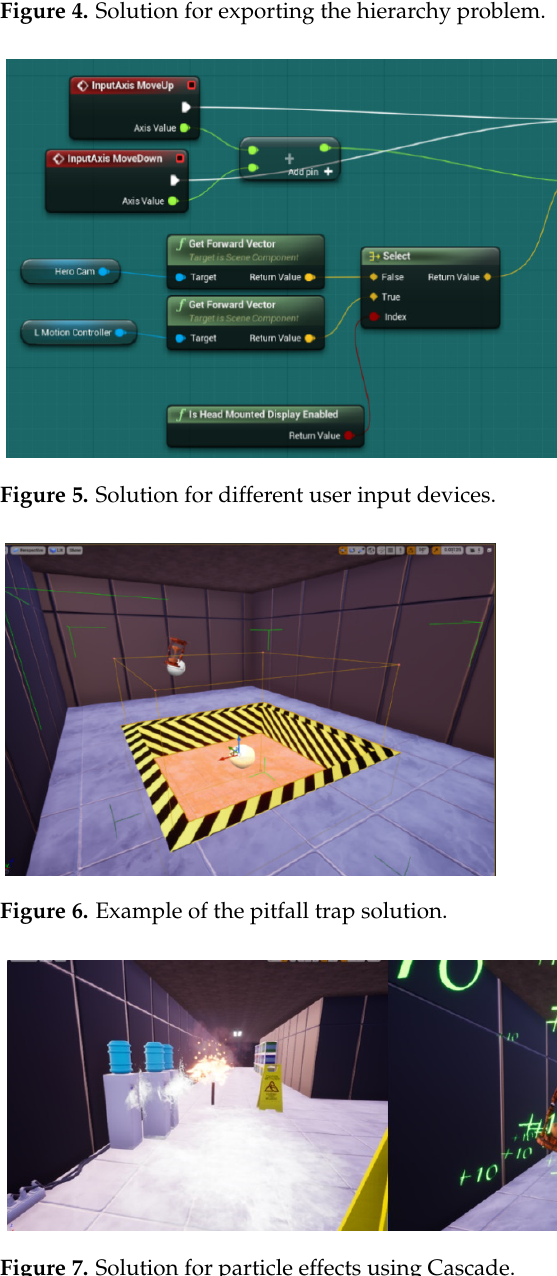
Figure 4. Solution for exporting the hierarchy problem .